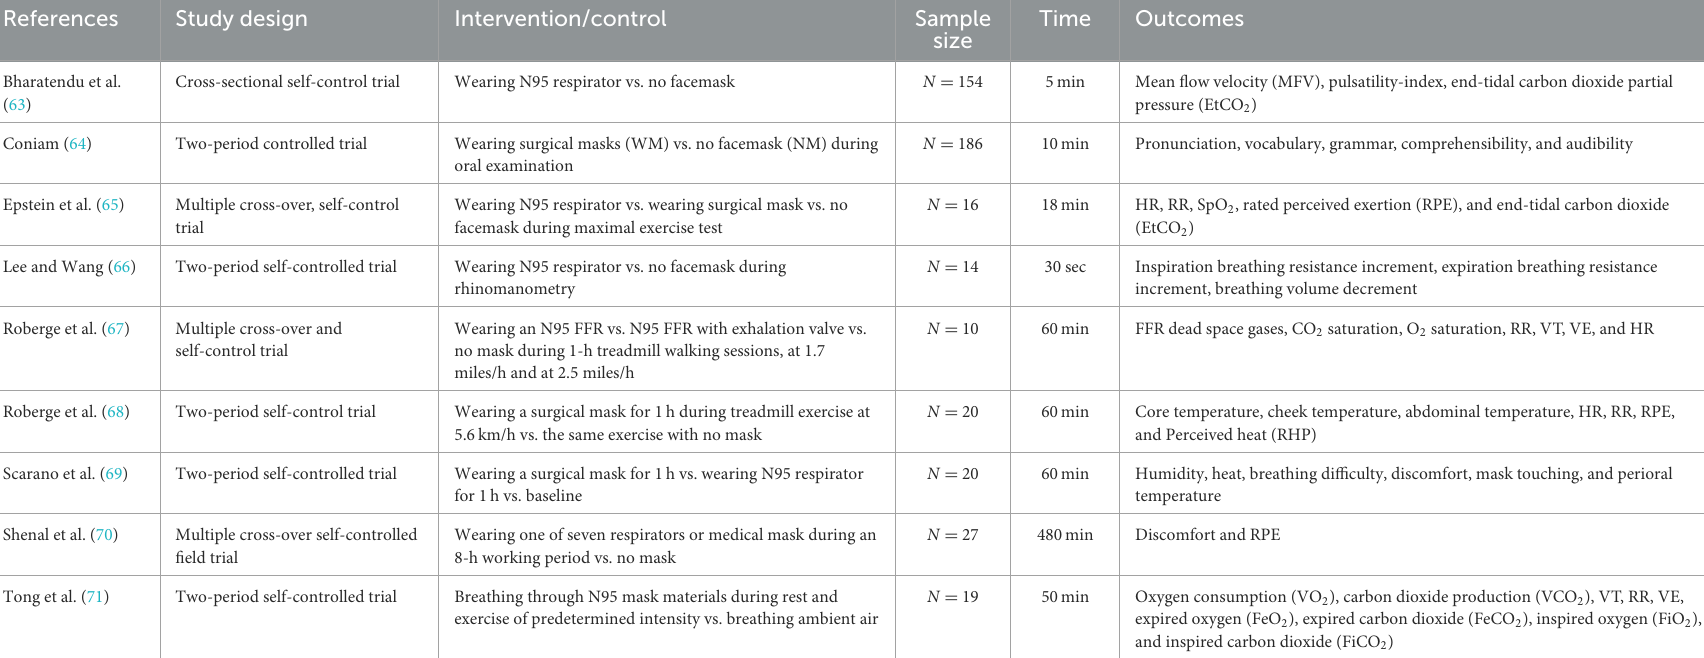
TABLE 1B Included nine non-randomized controlled